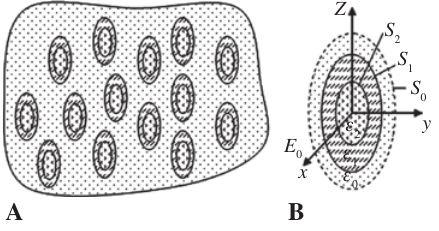
Figure 1: Scheme of a mixture with aligned bilayer ellipsoids (A) and the Bruggeman’s analytical model